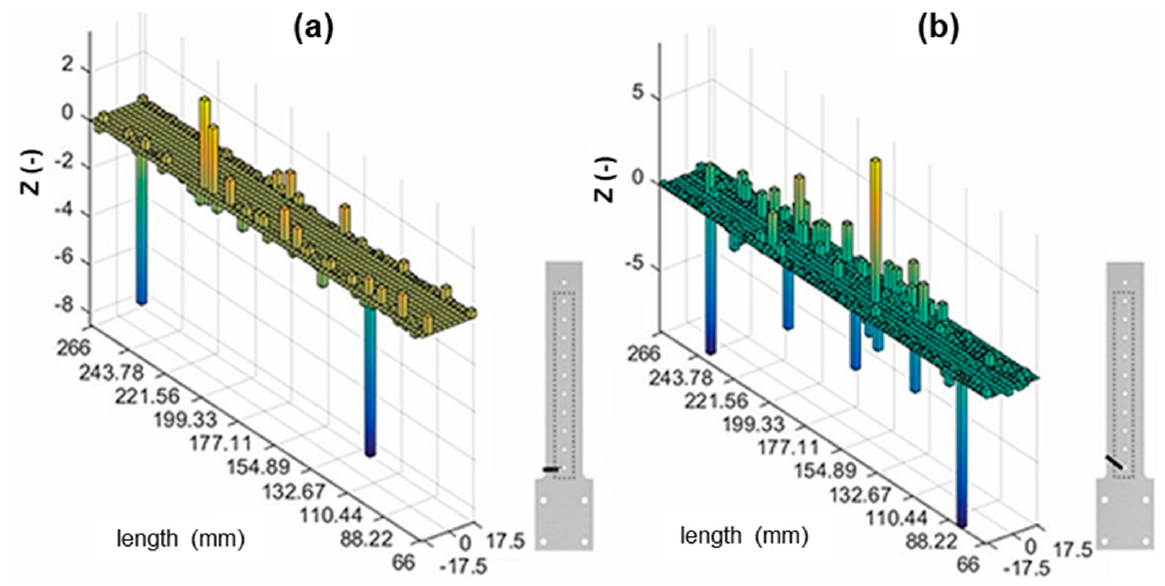
Figure 5. MSE-DI implementation (bottom layer) to hybrid-stiffened sample: ( a ) 0 ◦ cracked and ( b ) 30 ◦ cracked samples.